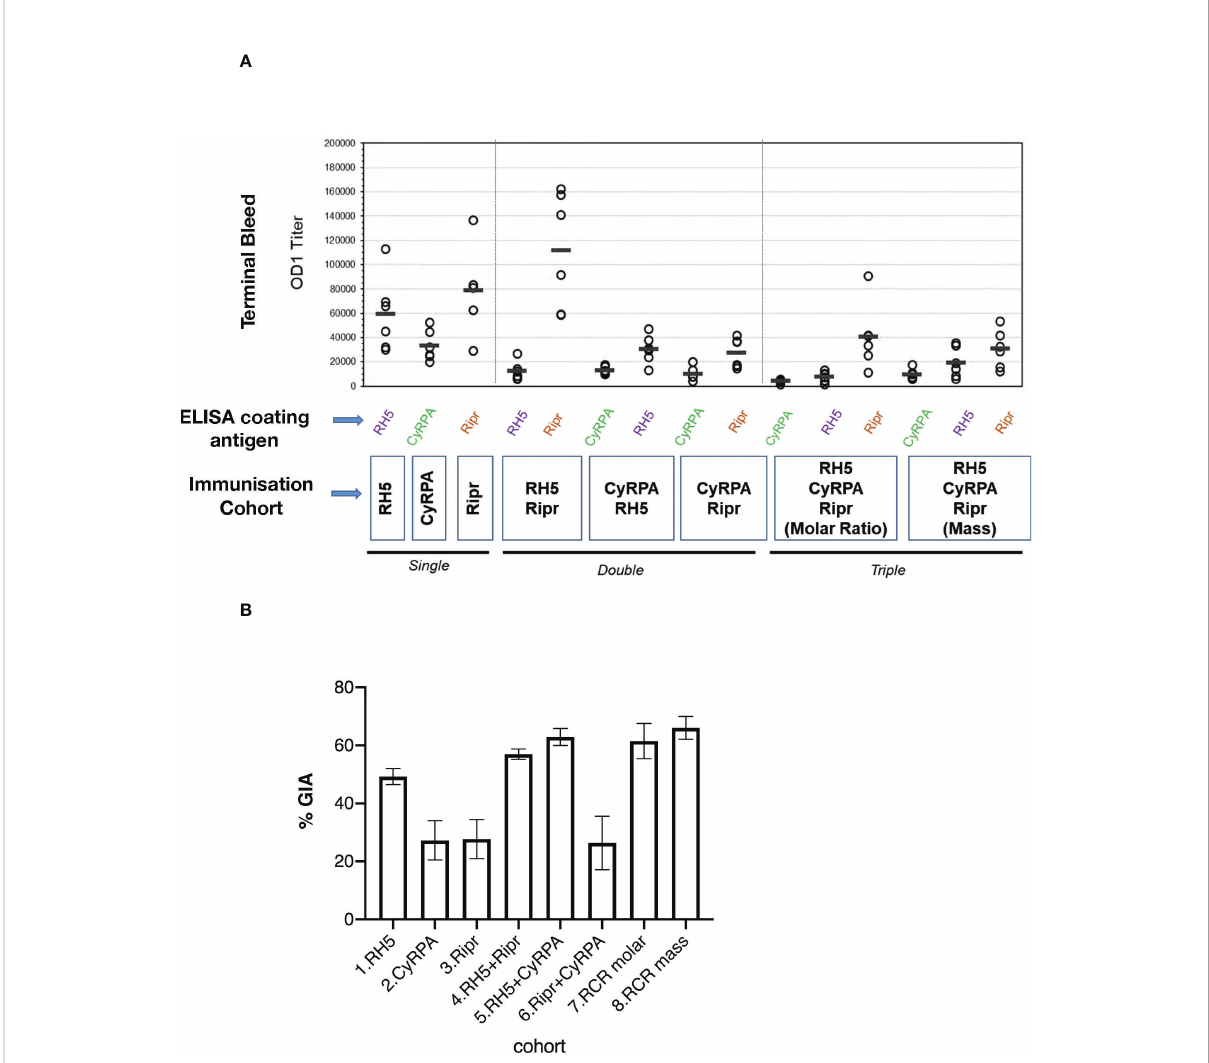
FIGURE 3 Functional activity is not correlated with immunogenicity in RCR multiple antigen combination immunisations. (A) Antibody reactivity in terminal bleed sera from individual rats was tested in ELISA against individual antigen components and the results are shown as OD1 titers calculated from 4PL curve fi ts based on the dilution curves of individual samples. Circles represent the OD1 titer from an individual rat serum titration and bars show the median of the six serum OD1 values. (B) GIA in IgG puri fi ed from individual rat sera. Bars show mean % GIA in each cohort of 6 rats at an IgG concentration of 2 mg/mL. Error bars show